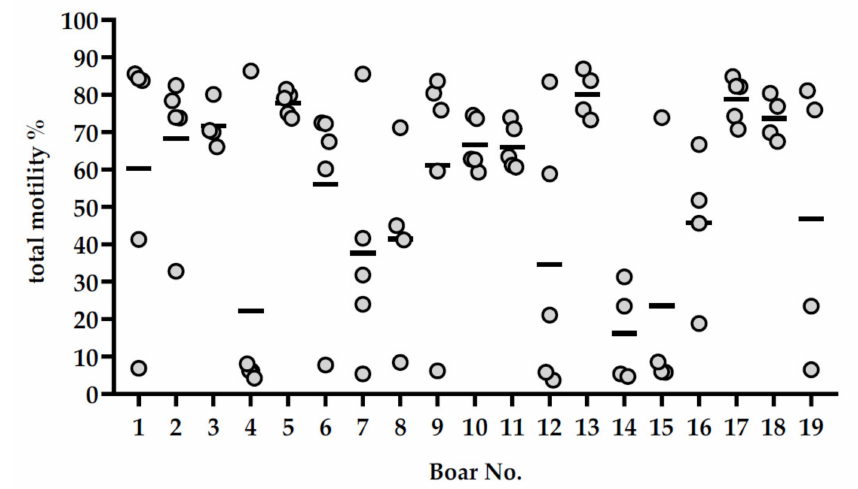
Figure 4. Sperm motility after 144 h of storage in single semen doses containing 10% ( v / v ) seminal plasma. Scatterplot showing the total motility (%) of semen samples with 10% autologous seminal plasma collected from 19 boars ( n = 4–5 ejaculates per boar). Dots show the values measured in each sample and the bars show the mean for each